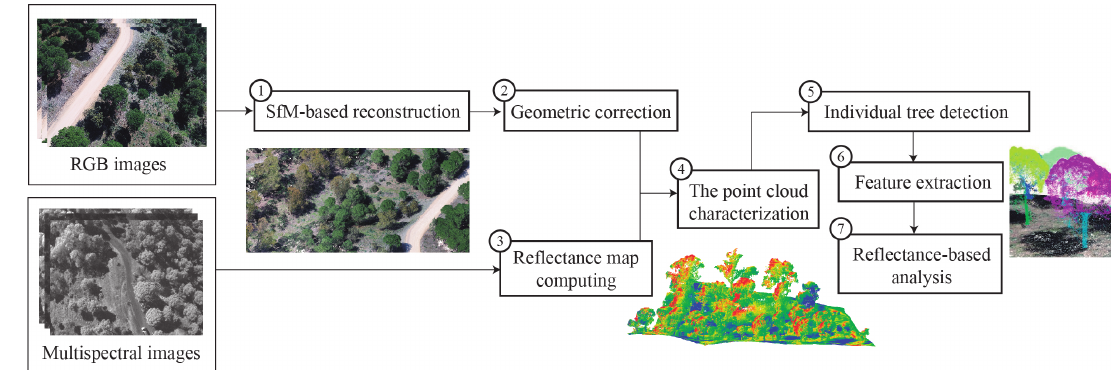
Figure 2. The flow diagram of the proposed